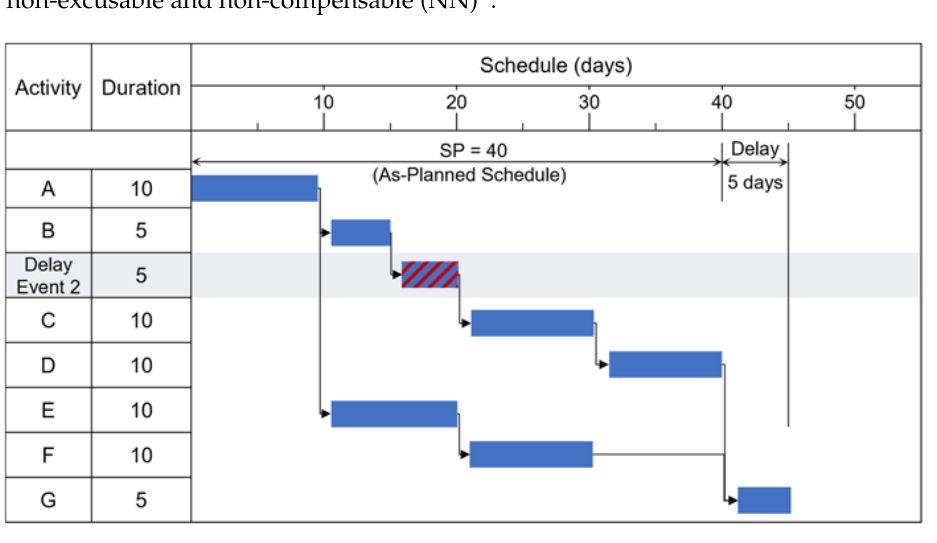
Figure 4. Impacted as-planned schedule by delay event 2 (contractor-caused delay). “Activity F” was completed 3 days earlier than as-planned. However, it is not reflected in IAP; only delayed events are added to the as-planned schedule. As shown in Figure 5, the IAP schedule by only “delay event 3”, its total project duration is 40 days. There is no delay because there is no change in the project duration according to the analysis. In this analysis, (owner-caused) delay event 1 and (contractor-caused) delay event 2 have 5 days of impact respectively when a single delay event is inserted without any other delay events. All of the delays are added up to 10 days. Owner-responsible delay (EC) is calculated by multiplying actual delay by owner-caused delays divided by the sum of all delays caused by the owner and contractors. The same method is used to compute the contractor-responsible delay